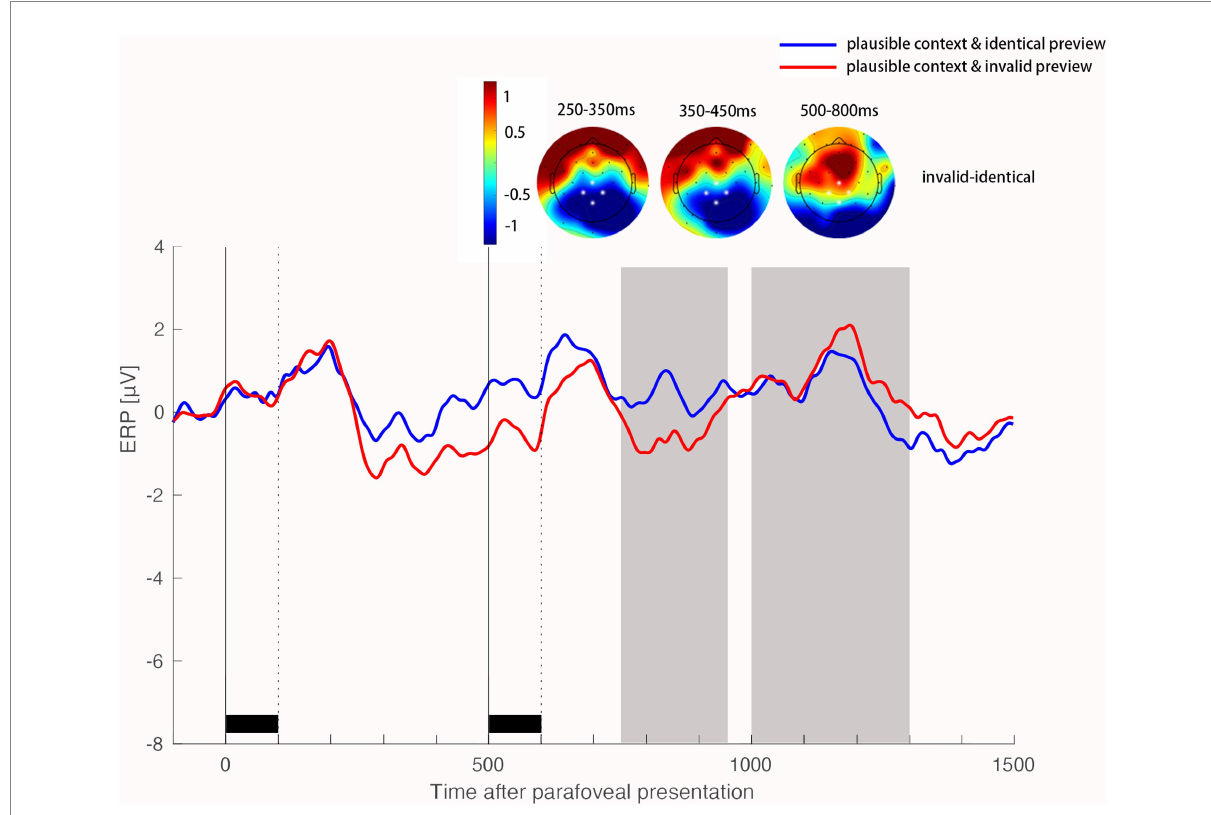
FIGURE 4 Identity preview benefit on the N400 and LPC components when the target word was plausible in the sentence. Time 0 on the time axis marks the onset of the target word in the right parafoveal position. ERP waveforms show the average activity in the ROI of four electrodes (highlighted in white in the topographic map) for the identical preview condition and invalid preview condition. Scalp topographic maps show the difference in ERP activity (invalid preview conditions minus identical preview conditions) in the time window of 250–350 ms, 350–450 ms and 500–800 ms after the onset of the target word in the foveal position,